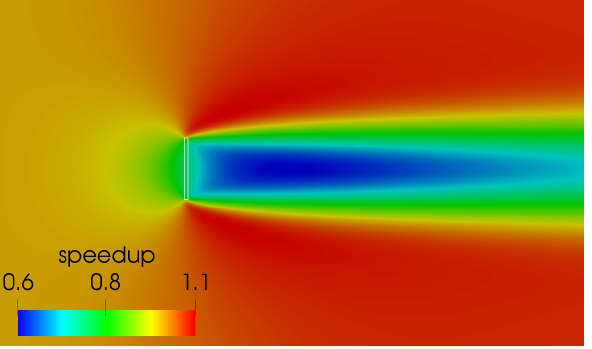
Figure 11. Wind speedup of our reference solution for a single